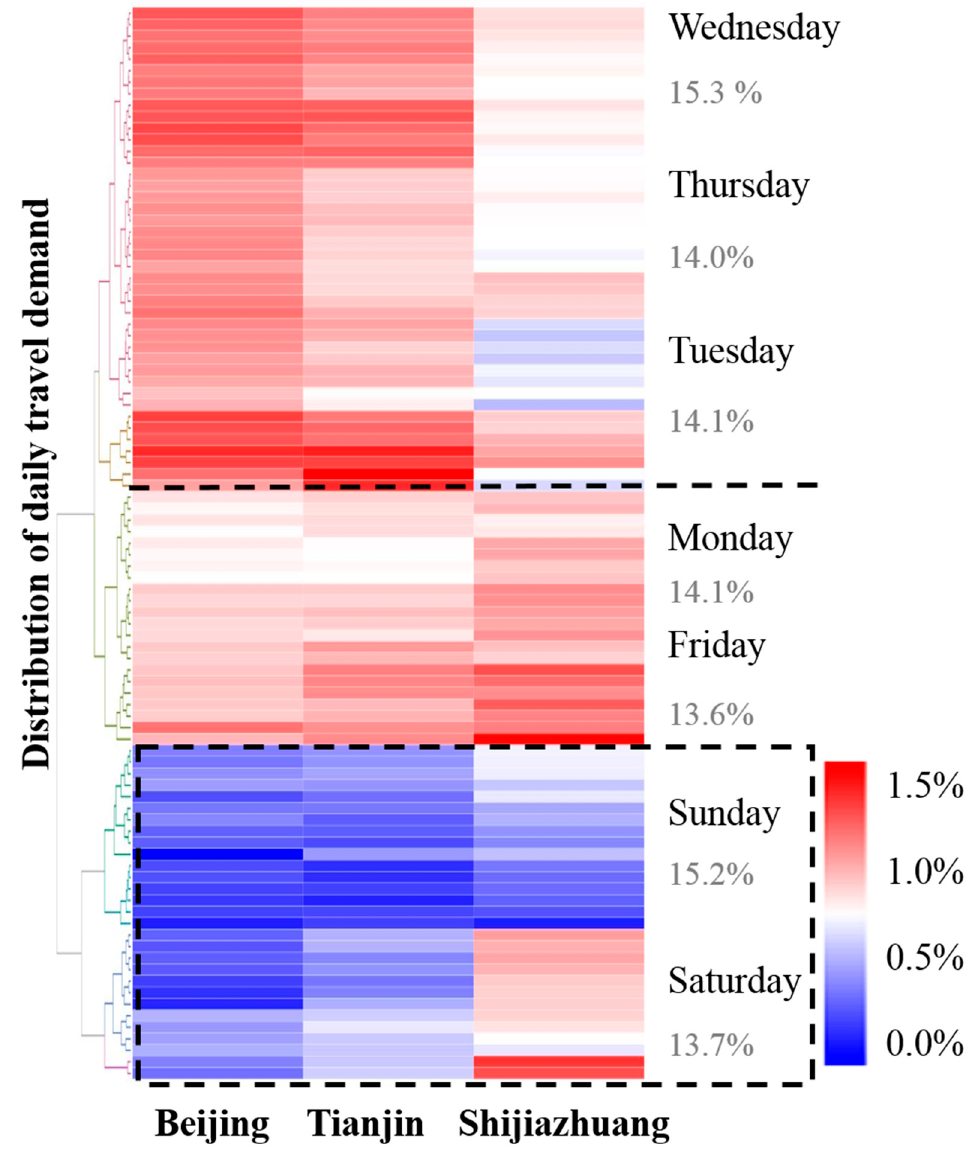
Figure 4. Order’s distribution by days.